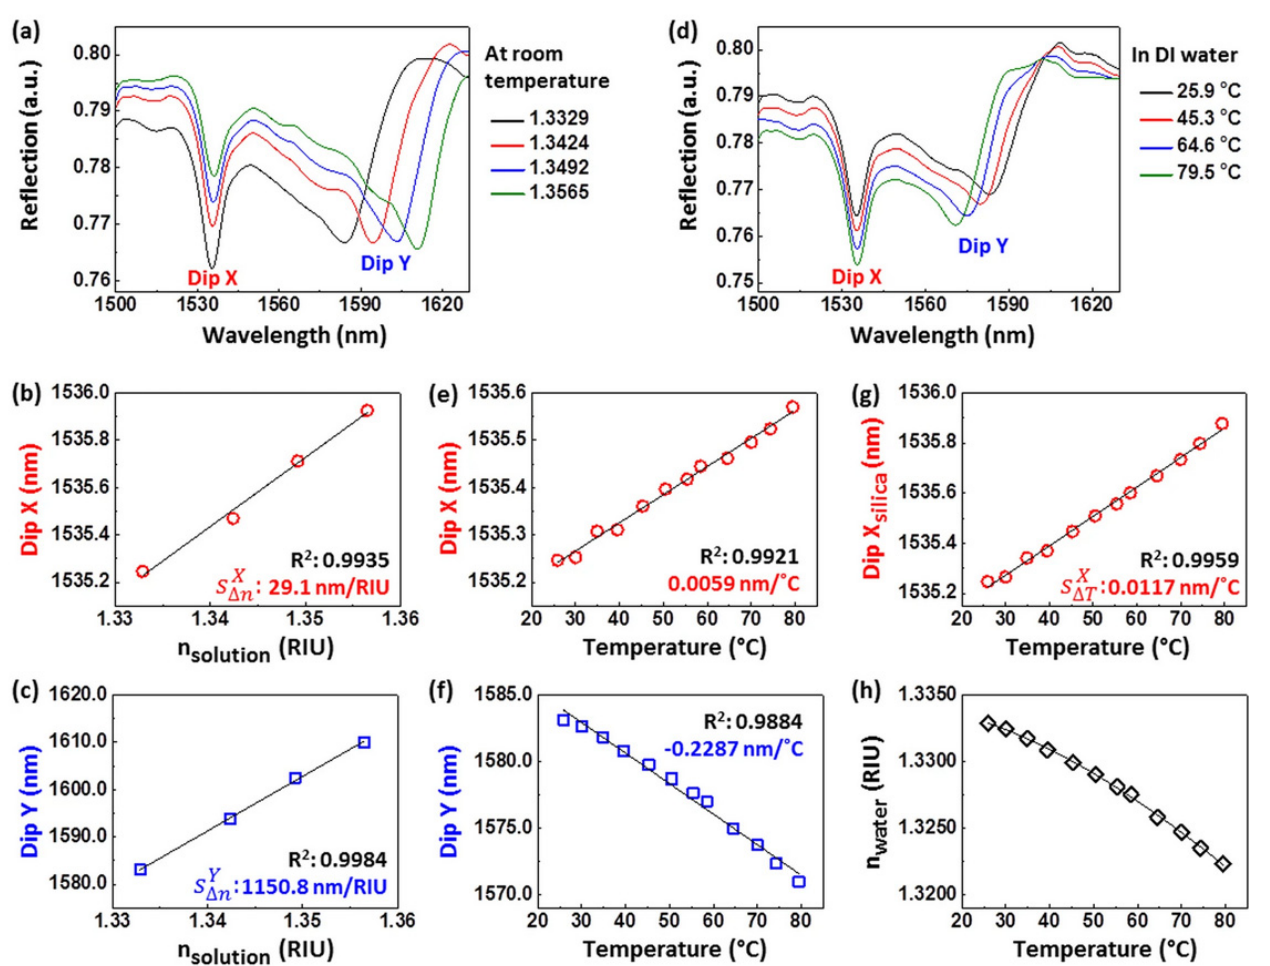
Figure 32. ( a ) Reflection spectra of the fabricated nanoprobe obtained for different reflective indices of glucose solutions at room temperature. Measured ( b ) Dip X and ( c ) Dip Y wavelengths as a function of refractive index of the glucose solution. ( d ) Reflection spectra of the fabricated nanoprobe obtained for different temperatures of DI water. Measured ( e ) Dip X and ( f ) Dip Y wavelengths as a function of DI water temperature. ( g ) Temperature-dependent Dip X shifts by the thermo-optic effect of silica only. ( h ) Refractive index of DI water as a function of temperature obtained from ( c , f ). Reprinted with permission of [95].